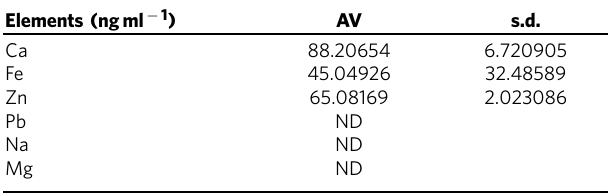
ND, not determined. Themetallicelementscontainedinthetumour-suppressivefractionwereinvestigatedbyatomic absorption